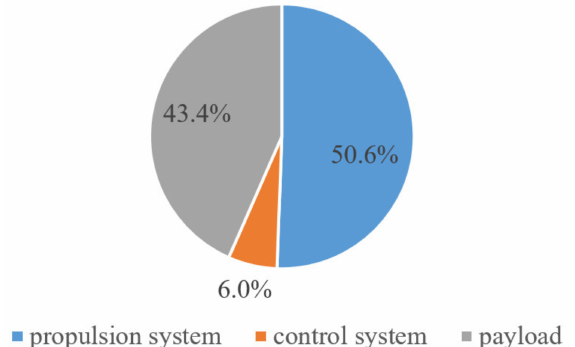
Figure 2. The proportion of energy consumption.